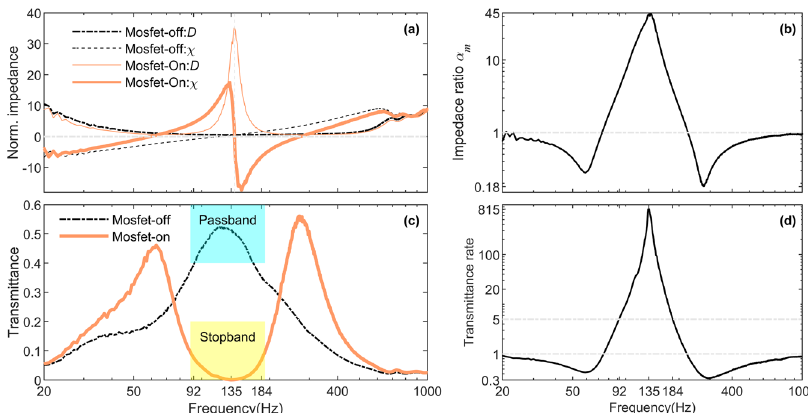
Fig. 2 Results of the acoustic impedance measurement. a Acoustic impedance of the meta-layer, D þ i χ , for MOSFET-on and -off states. Both damping ( D ) and reactance ( χ ) are normalized by the air impedance ρ c A . The dynamic mass, damping, and stiffness of the diaphragm are M = 5.8 g, 0 0 D = 5.04 N s m − 1 , and K = 4516 N m − 1 , respectively, with force factor Bl = 4.6 T m. The effective resistance, inductance and capacitance are R = 0.1 Ω , L = 1.2 mH, and C = 1.0 mF, respectively. b Impedance modulation ratio α . c Sound transmittances showing passband and stopband at MOSFET-off and m -on states, respectively. d Ratio of transmittances for the MOSFET-off and -on